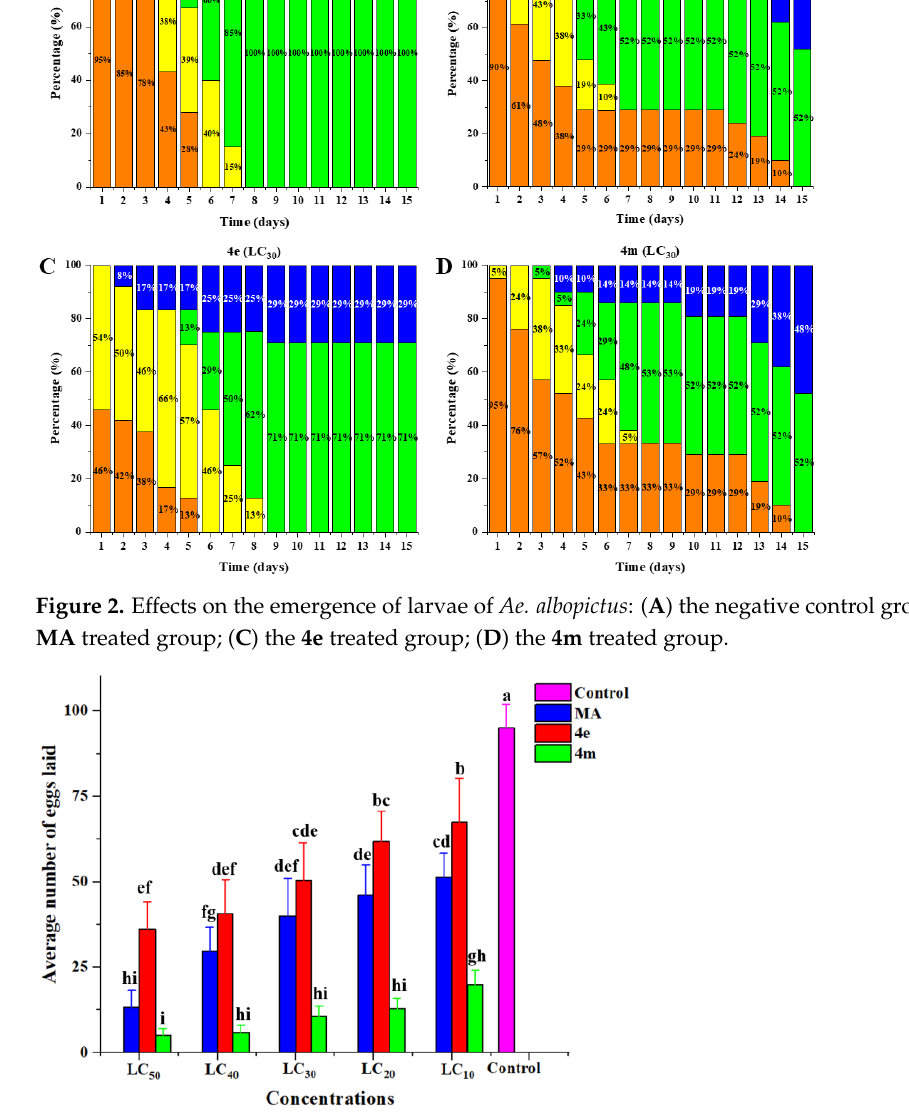
Figure 3. Effects on the fertility of female adult mosquitoes of Ae. albopictus . Error bars show 95% confidence intervals (CI). Different letters indicate significant differences at p < 0.05.